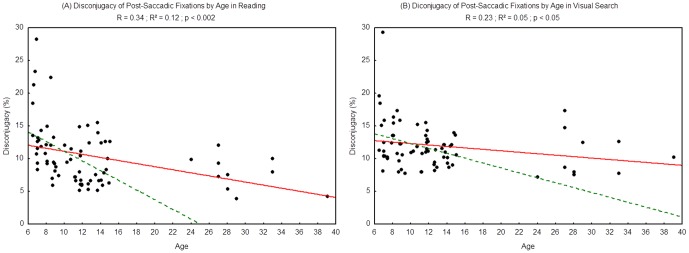
Mean value of post-saccadic fixation disconjugacy during reading (A) and visual search (B).Lines represent the corresponding regressions. Dotted lines represent the regressions for children only (from 6 to 15 years old), 2A: R2 = 0.13, p<0.003; 2B: R2 = 0.09, p<0.02.